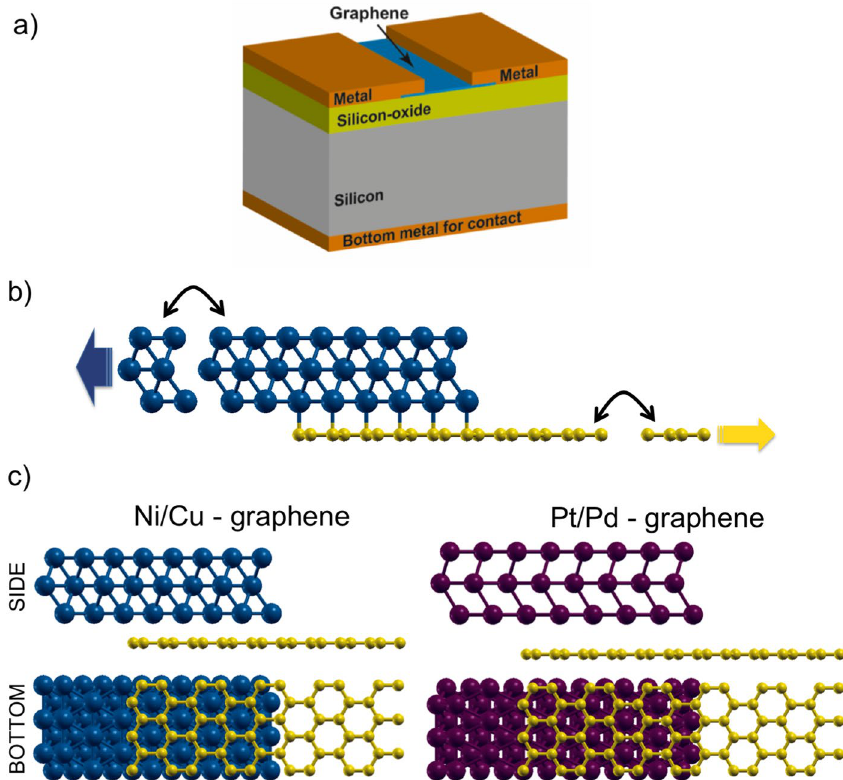
Figure 1. Graphene-metal interface. ( a ) Sketch of the graphene-metal contact with back-gate. ( b ) Schematic representation of the graphene-metal transmission model. Semi-infinite leads are attached on the left (metal) and on the right (graphene) of the simulated structure. ( c ) Side and bottom views of the scattering regions considered for the density-functional theory and transmission calculations, for the Ni-, Cu-, Pt- and Pd- graphene